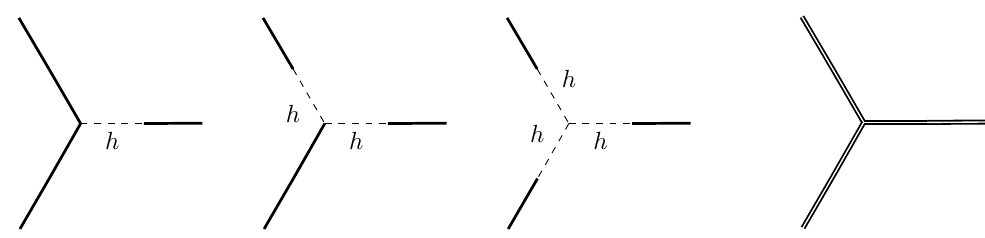
Figure 6 . Diagrams in the weak-mixing limit for the single (left), double (middle-left) and triple (middle-right) (cid:30) - h exchange processes in the three-point correlation functions. In the strong-mixing limit, the triple exchange diagrams converge to the contact diagram given by the right panel, where double solid lines denote the mixed (cid:30) - h propagator